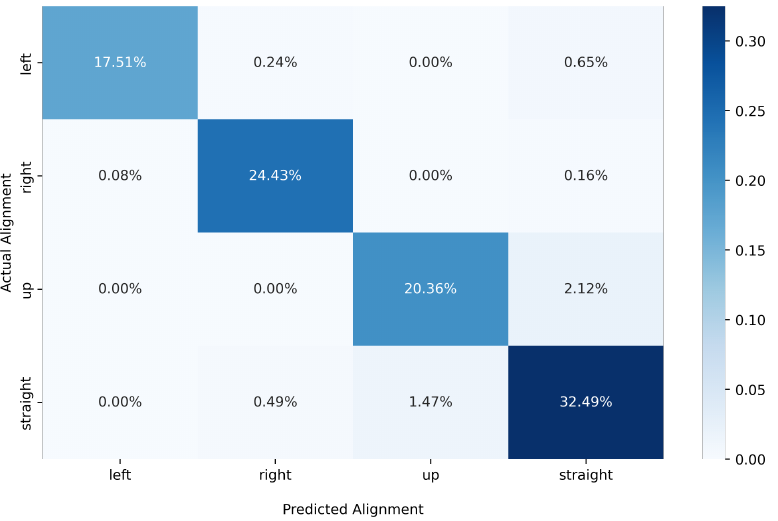
Figure 7. CMU Face Orientation Confusion Matrix.